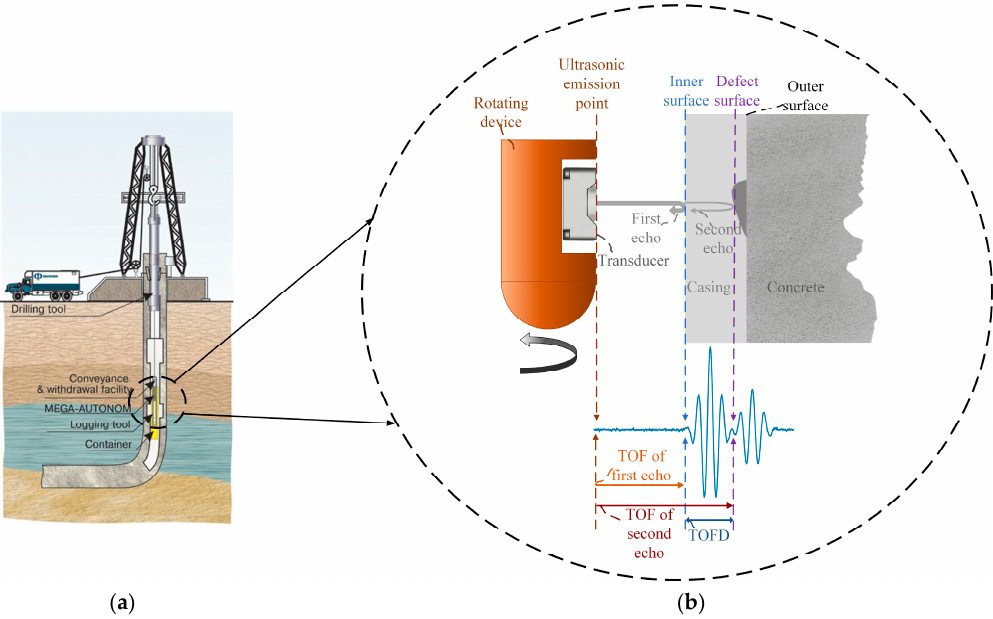
Figure 1. Overview of ultrasonic non-destructive testing in buried pipelines. ( a ) The structure of drilling well; ( b ) The principle of thickness measurement of buried pipelines via ultrasonic.